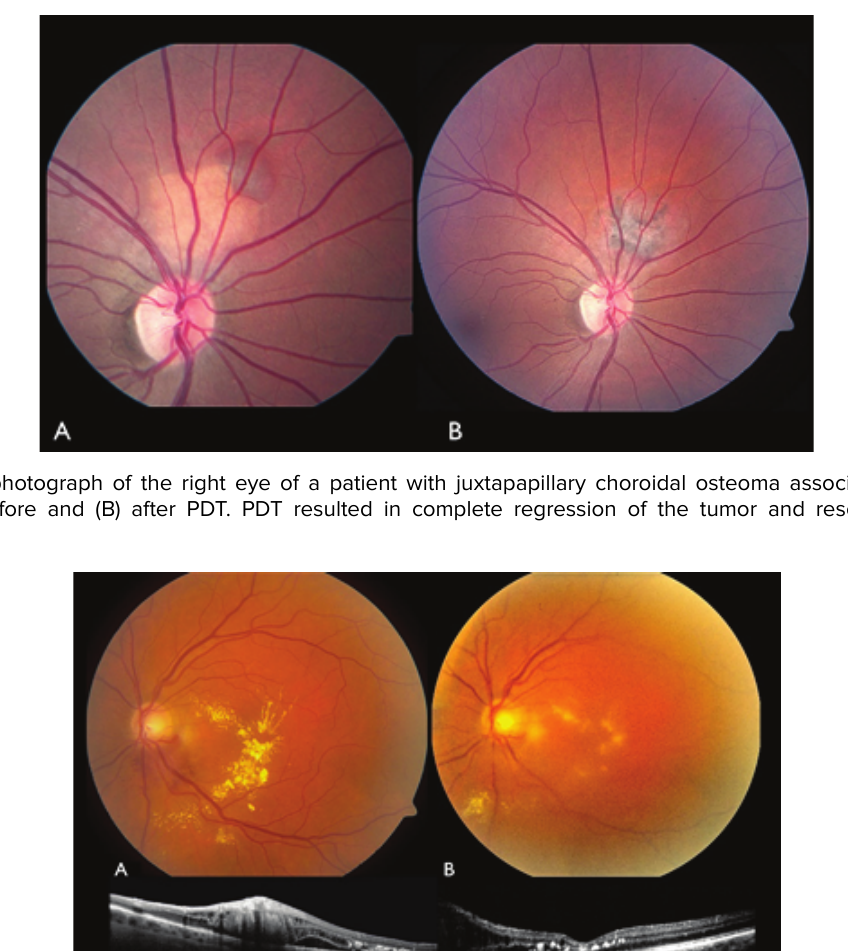
Figure 1. Fundus photograph of the right eye of a patient with choroidal hemangioma located in the macula (A) before and (B) three months after photodynamic therapy (PDT). B-scan ultrasonography (C) before and (D) after PDT revealed a decrease in tumor thickness.